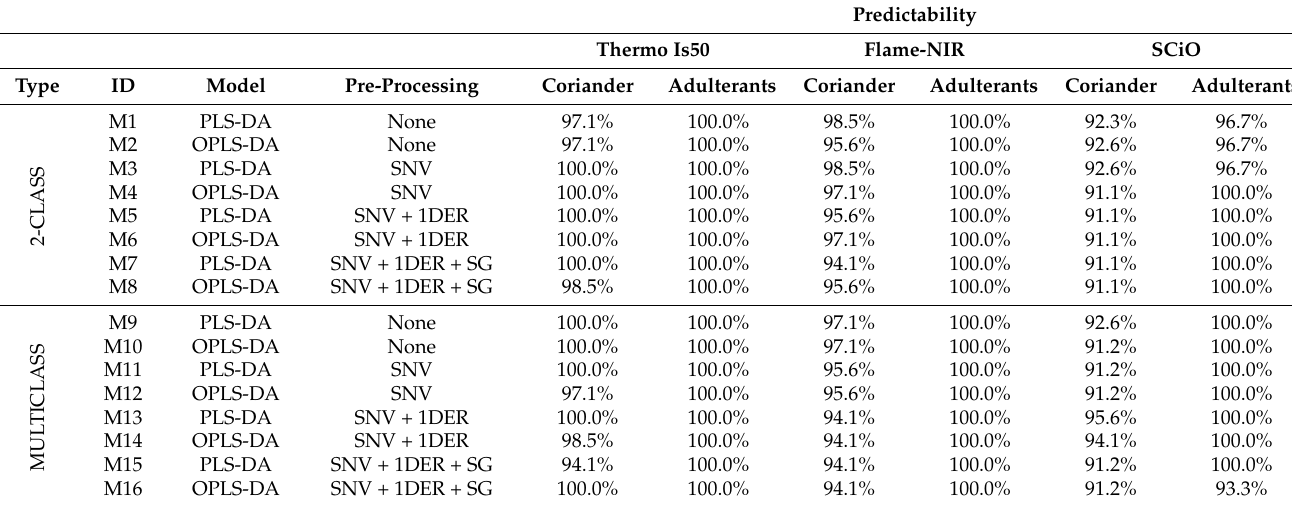
Table 2. Predictability of the two-class and multiclass models developed and externally validated ( n = 98) using SIMCA 15